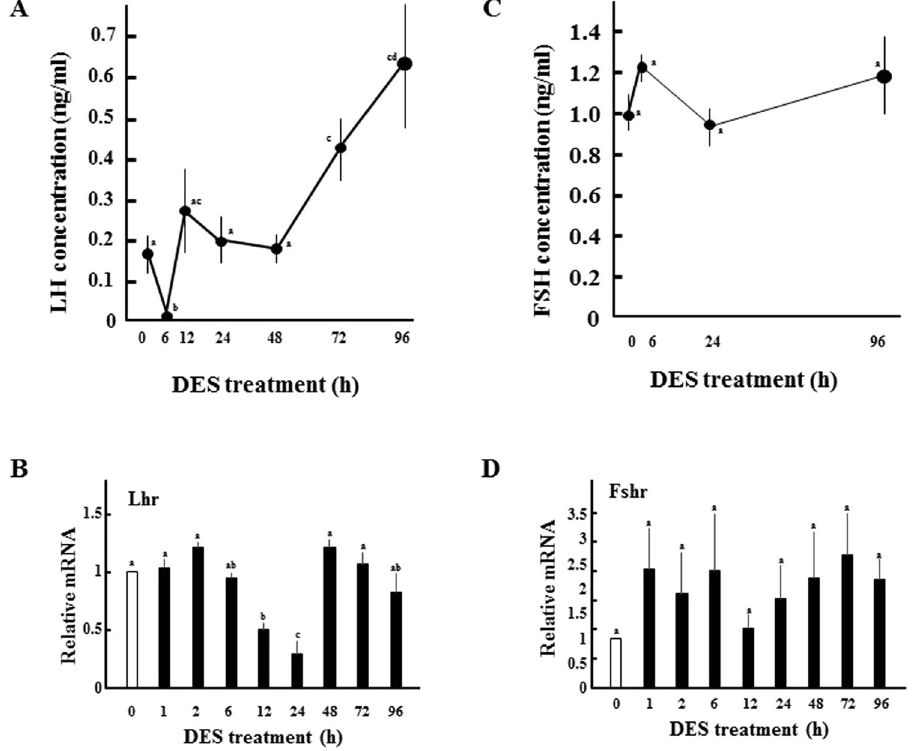
Figure 2. Effects of DES on serum gonadotropin levels and expression of ovarian cognate receptors. Concentrations of LH ( A ) and FSH ( C ) in immature female rats treated with DES for the indicated time. Data for each point are from five animals (the means ± SEM). Expression of ovarian LH receptor (LHR; B ) and FSH receptor (FSHR; D ) in immature rats treated with DES for the indicated time. Expression of each gene was analyzed by Q-PCR and normalized to 36B4 expression. Q-PCR data represent the mean ± SEM of at least four independent samples. Values marked by different letters are significantly different ( P < 0.05).